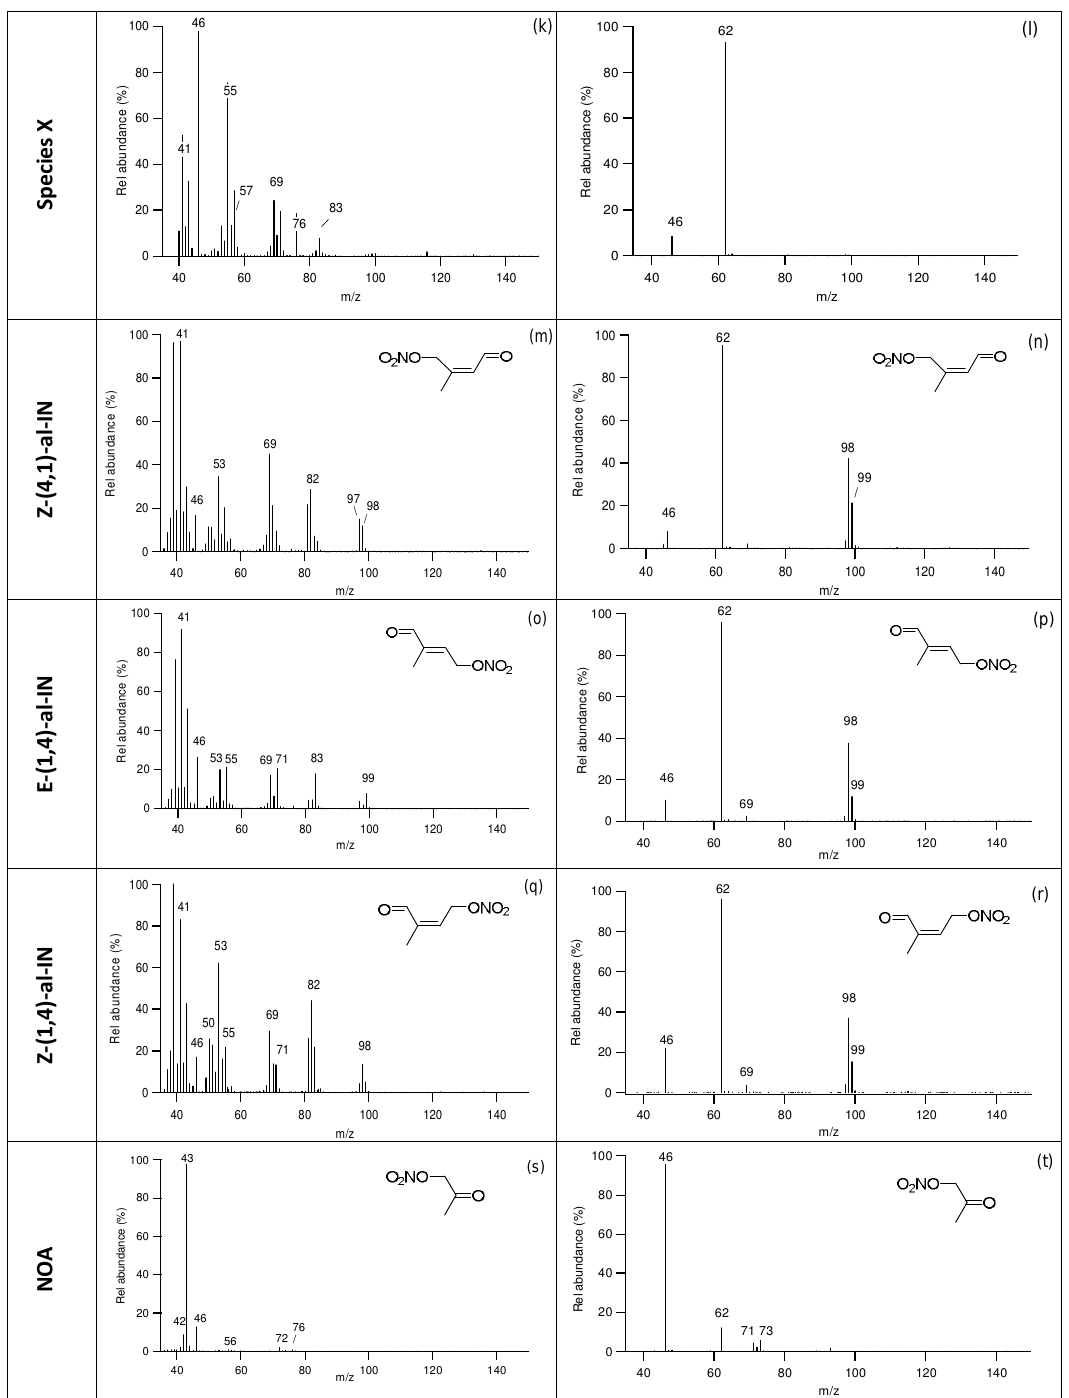
Figure 2. Mass spectra (EI left, NI right) of isoprene nitrates (4,3)-IN (a, b) , Z-(1,4)-IN (c, d) , E-(1,4)-IN (e ,f) , Z-(4,1)-IN (g, h) , E-(4,1)- IN (i, j) , species X (k, l) , Z-(4,1)-al-IN (m, n) , E-(1,4)-al-IN (o, p) , Z-(1,4)-al-IN (q, r) , acetone nitrate (s, t) . Mass axes are limited to m/z below 150 for clarity; however scans were to higher m/z but no ions above this m/z were observed for any compounds. EI and NI mass spectra for all the synthesised INs, including more annotated versions of those shown here, are in the